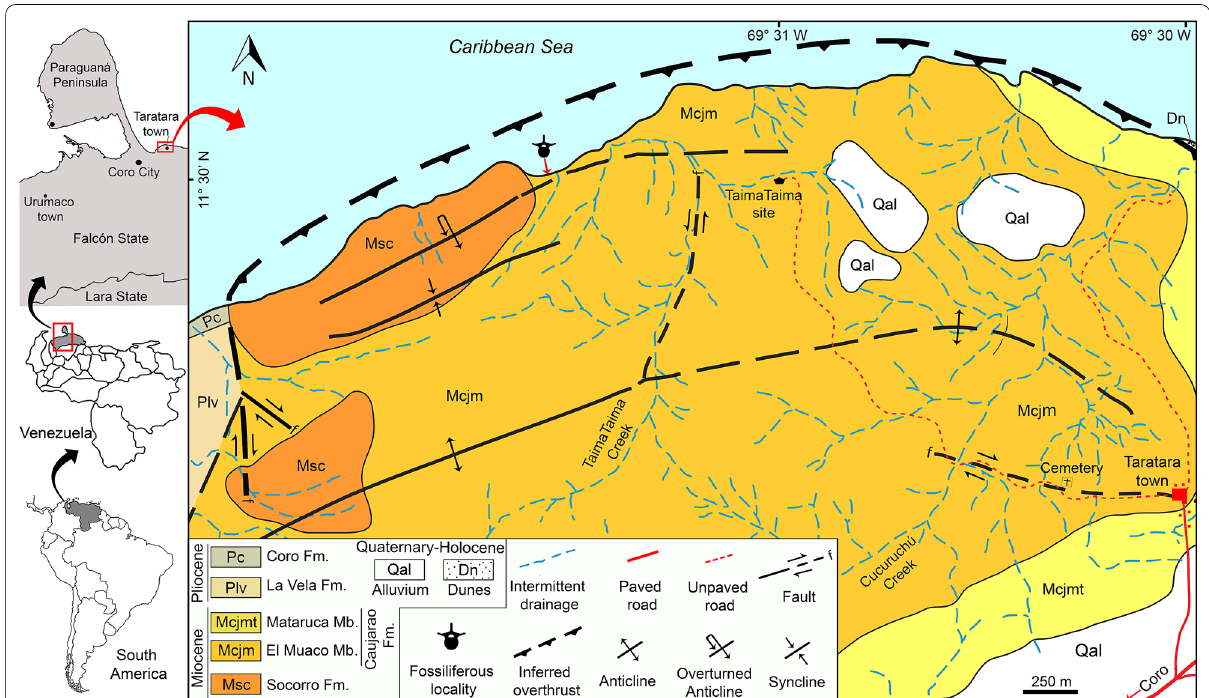
Fig. 1 Map indicating the geographical location, general geology of the study area and fossiliferous locality of the specimen